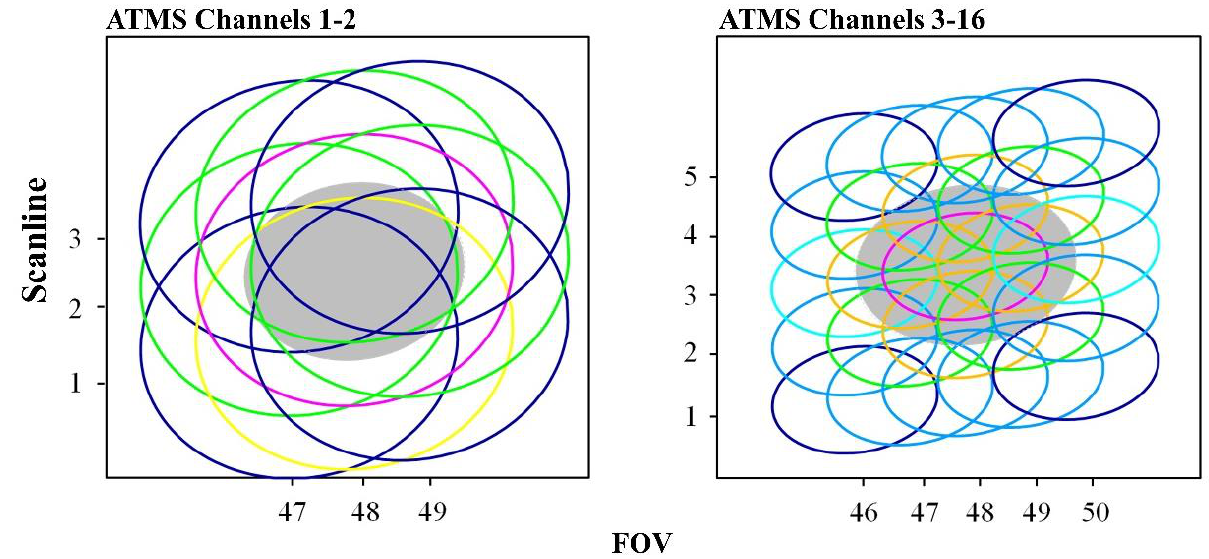
Figure 2. Schematic diagram of resampling ATMS antenna brightness temperature using BGI (the colored hollow ellipse represents the original observation FOV, and the gray solid ellipse represents the FOV at the target resolution).